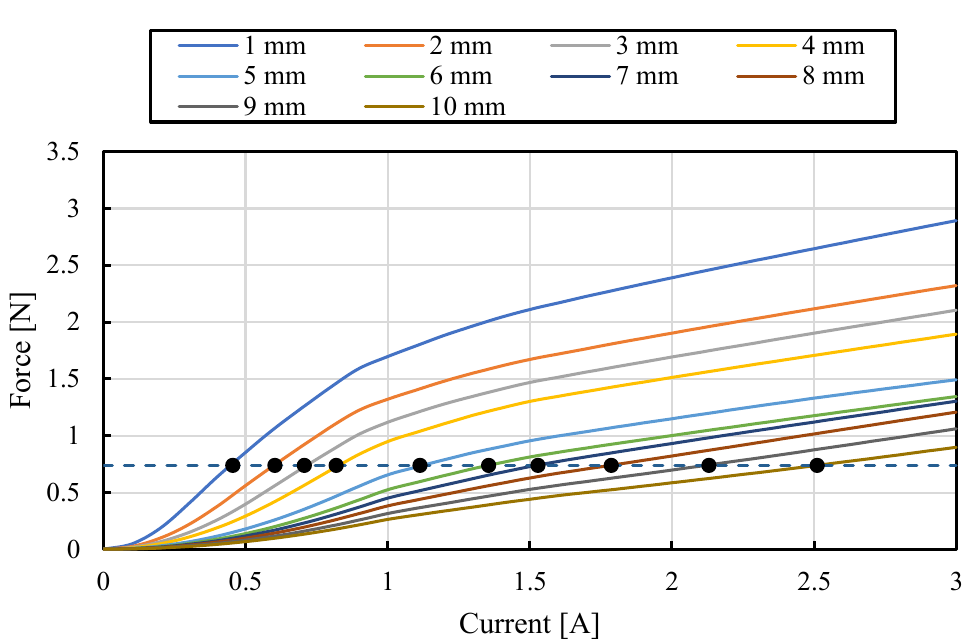
Figure 5. Relationship between the current of an electromagnet and the force of the steel plate in each gap. The dashed line shows the weight of the steel plate. The dots ( · ) show intersection points